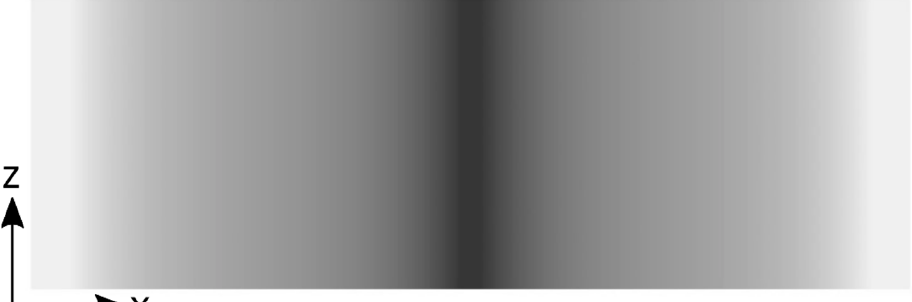
Figure 4. A light intensity pattern is caused by strong anchoring at the bottom surface and the sides before introducing the surfactant at the aqueous interface at a steady state. Gray scales indicate the relative intensity of optical interference. White indicates the maximum relative intensity, while black indicates the minimum relative intensity.